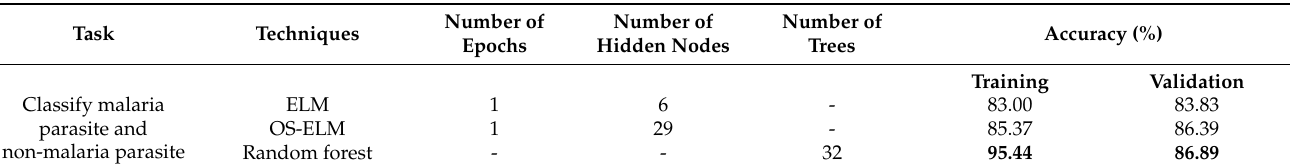
Table 7. The performance comparison among ELM, OS-ELM, and random forest networks for classification between malaria and non-malaria parasites.